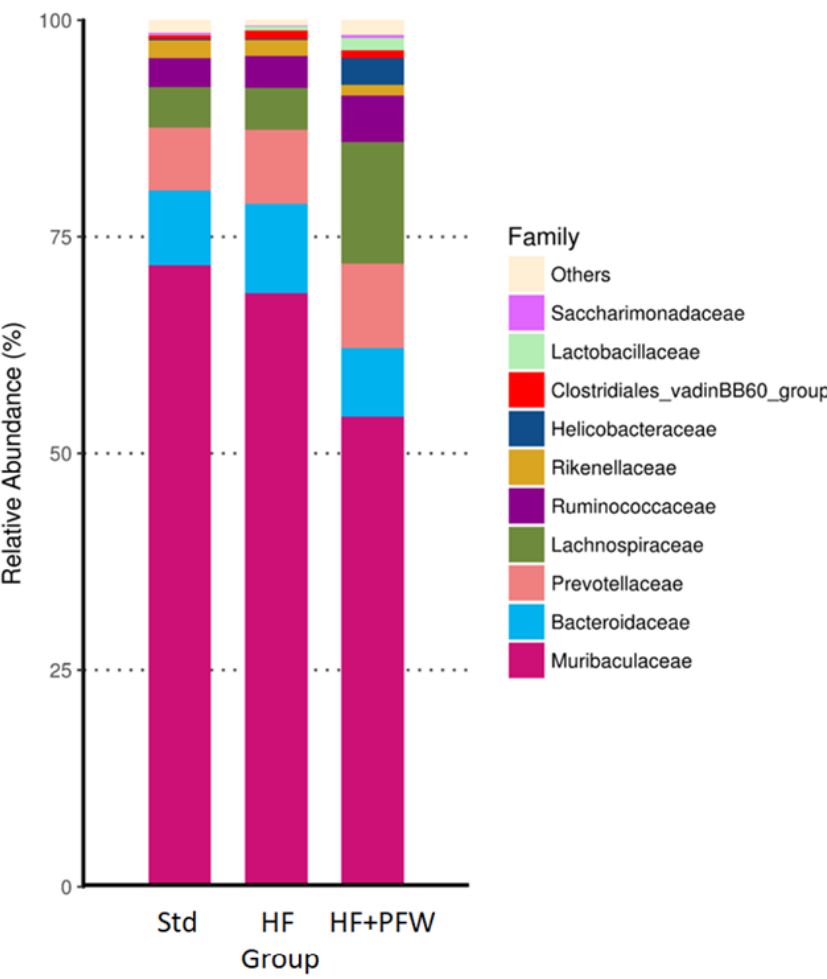
Figure 6. Taxa analysis of gut microbiota composition in mice by relative abundance bar chart. Top 10 classifications for family level are shown. Taxa not in the top 10 are grouped together in the others category. Group Std, standard diet; group HF, high-fat diet; group HF+PFW, high-fat diet plus PFW treatment.